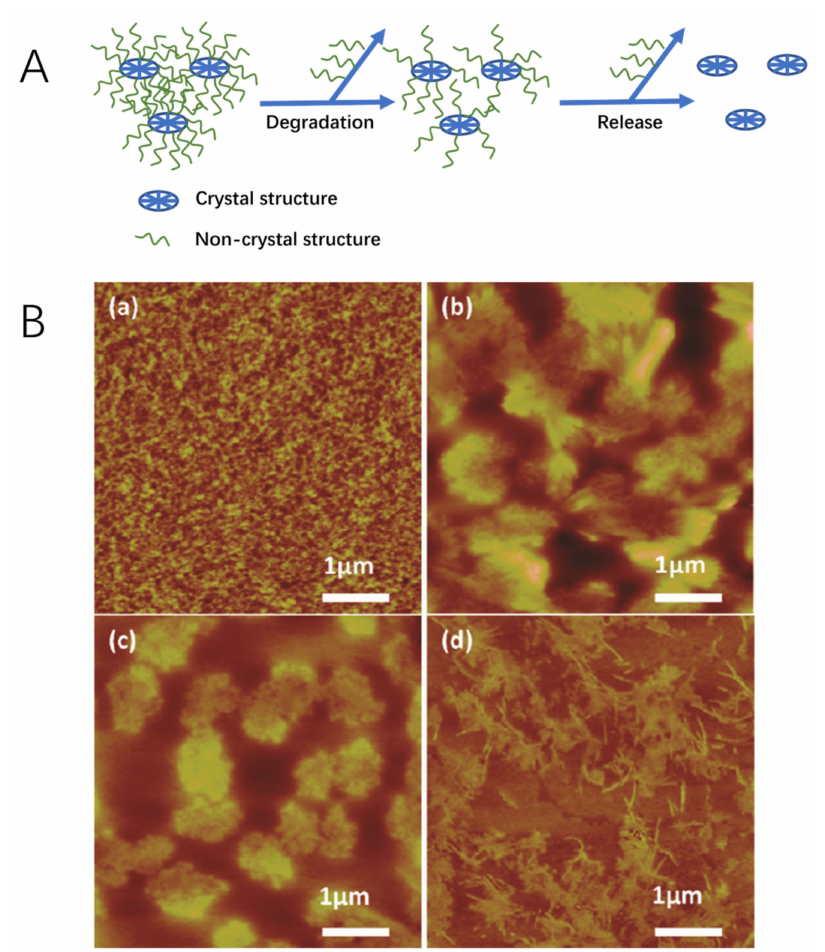
Figure 2. ( A ) Schematic illustrating the SF degradation process mechanism. ( B ) Representative AFM images of ( a ) pure protease XIV solution and differently fabricated SF films: ( b ) slow drying process, ( c ) water annealing treatment, and ( d ) stretching treatment, after 12 h of exposure to protease XIV solution. The degraded SF particles that dissolved in protease XIV can be seen in ( b ), ( c ), and ( d ). Reproduced with permission from